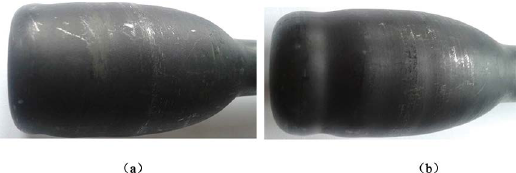
Figure 13: The forming results in experiment (a) under the three- stage current mode, (b) under the constant current mode.